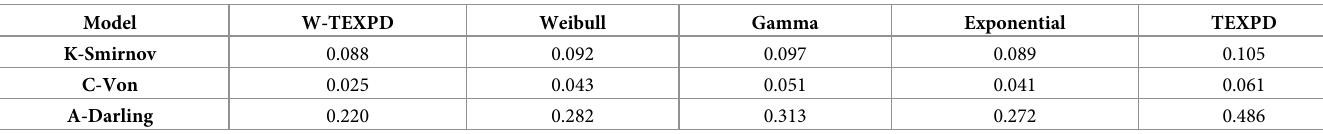
Table 13. Goodness of fit statistic.